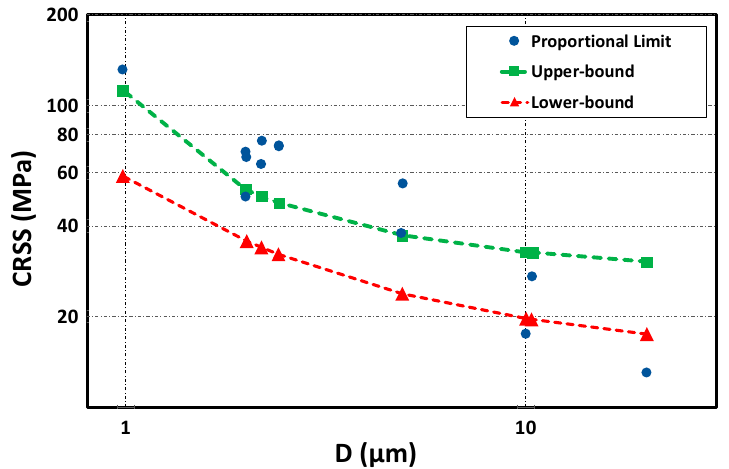
Figure 11. A comparison between the lower and upper bounds of Equation (9) with the experimentally measured proportional limits of Ni micropillars (after Norfleet et al. [56]).